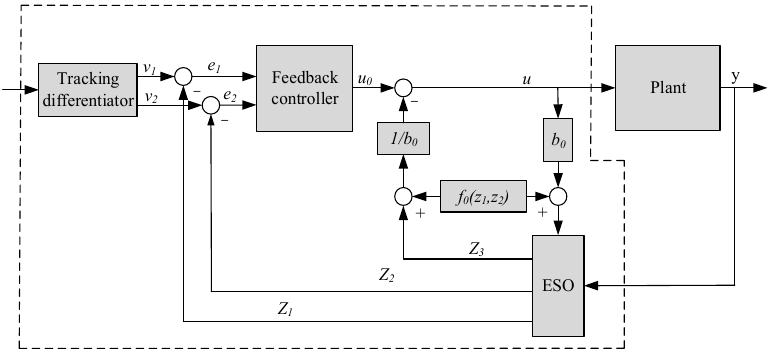
Figure 2. Principle of MADRC. angle, and the roll angle, i.e., v 1i = 0 , a tracking differential does not need to be designed in the controller to extract the input.